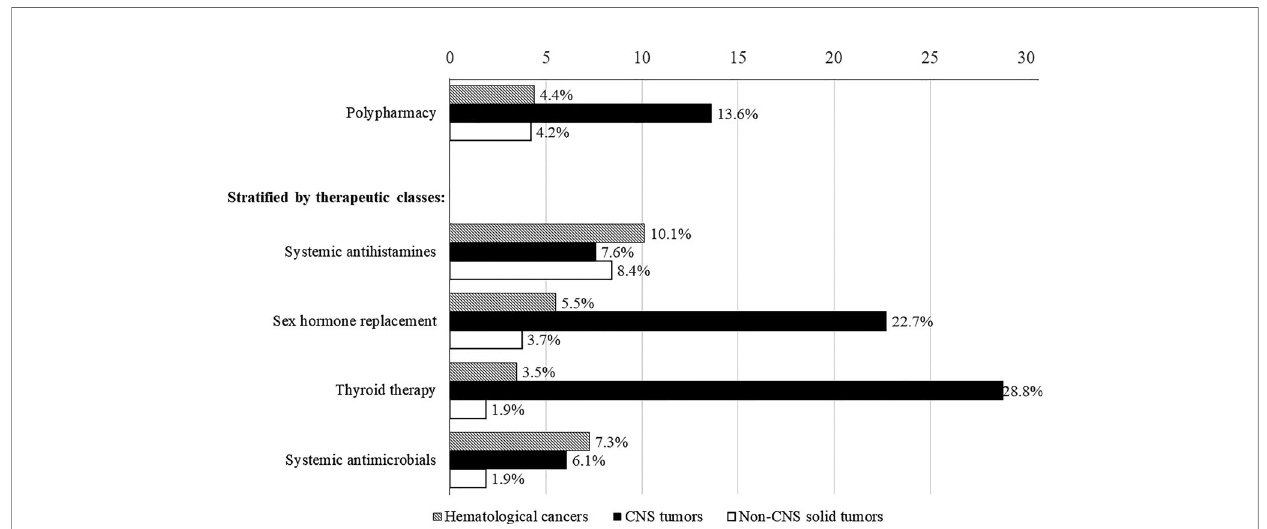
FIGURE 2 | Rates of polypharmacy and medication use strati fi ed by cancer diagnoses. Includes only therapeutic classes used by more than 10% of survivors prescribed with chronic